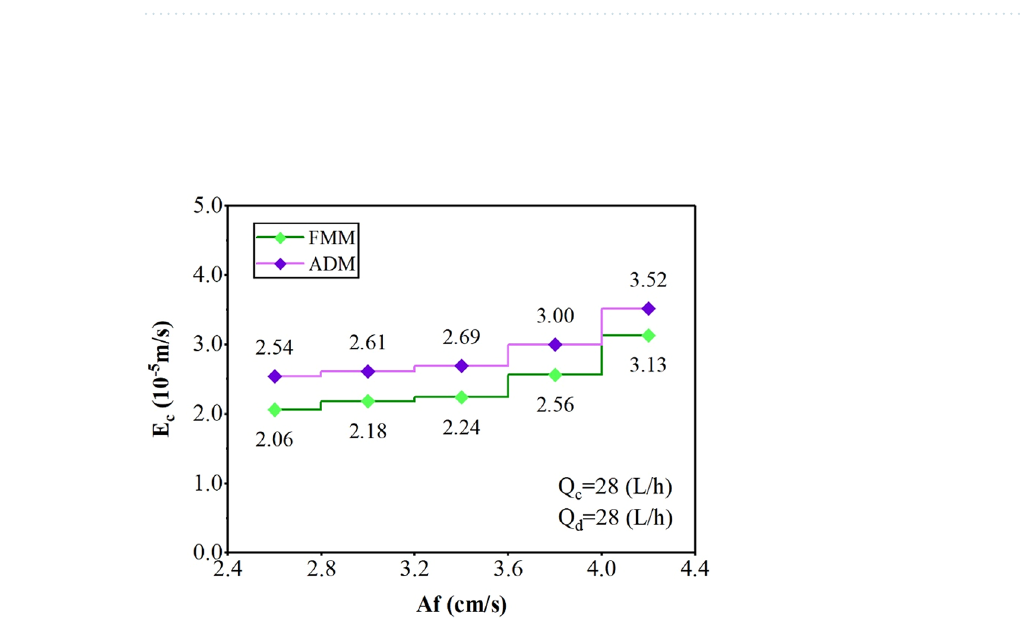
Figure 6. The effect of operating parameters [( a ) pulsation intensity, ( b ) aqueous phase flow rate, and ( c ) organic phase flow rate] on the dispersed phase backflow coefficient.